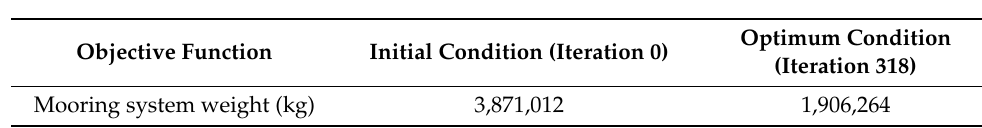
Table 7. Objective function results for case